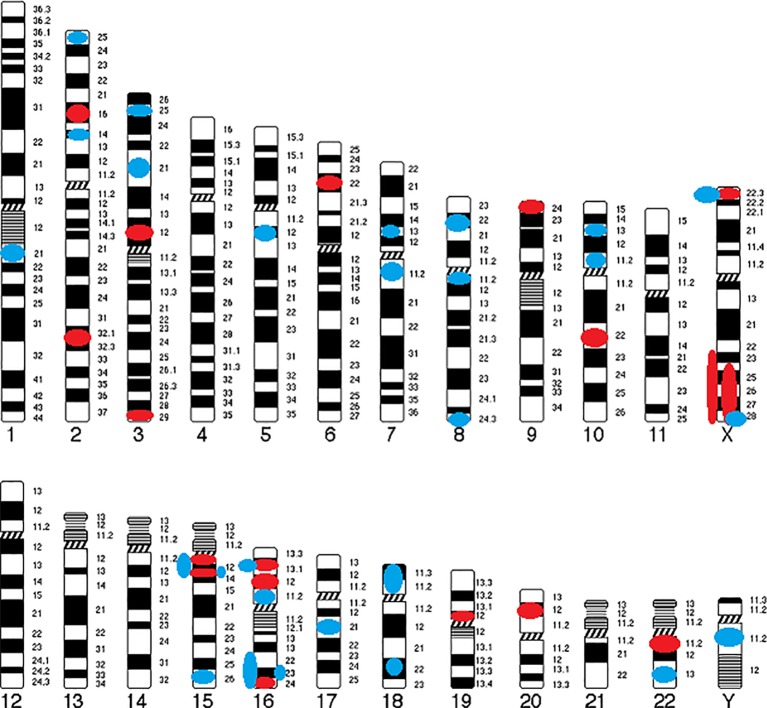
Genomic map of CNVs identified in COS. Circles indicate their position and color represents type of abnormality (Red circle, deletion; Blue circle, duplication).